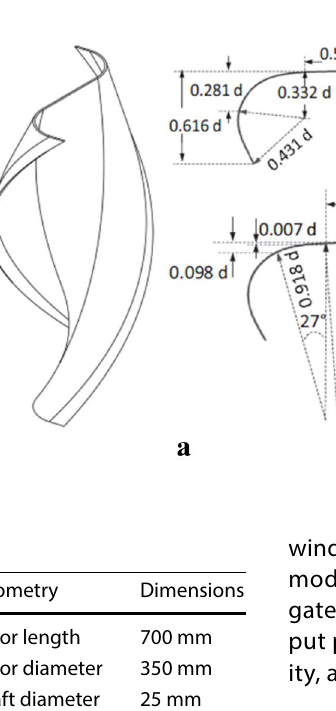
Fig. 2 a Schematic of the improved Bach model; b Sche- matic of the Bach model